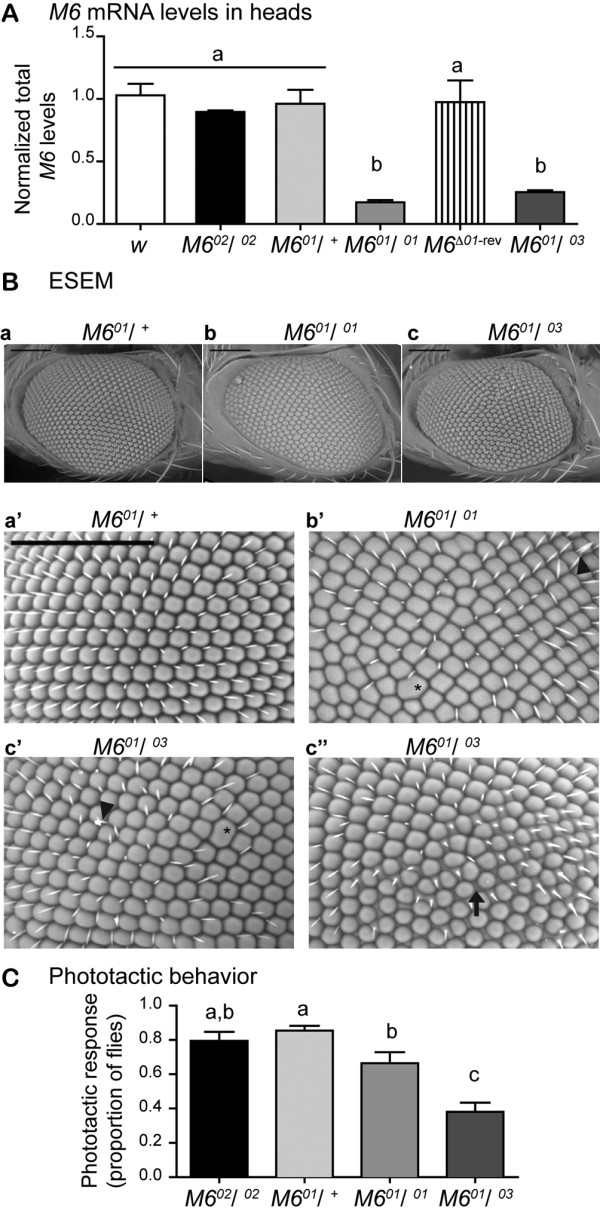
M6downregulation triggers a mild rough eye phenotype and impairs the phototactic response. (A) M6 mRNA levels in heads of control (w), M602/ 02, heterozygous and homozygous M601, M6Δ01-rev (M601 P-excised), and the trans-heterozygous M601/ 03 mutants were assessed by RT-qPCR. The values shown are relative to the control genotype (white bar). Mean ± SEM, n = 3–5. Kruskal-Wallis test, p < 0.001, followed by a multiple comparison test. Different letters indicate significant differences. (B) Representative images of young male fly eyes taken with an environmental scanning electron microscope (ESEM). Eyes of heterozygous M601/ + used as control (a, a’), homozygous M601/ 01 (b, b’) and trans-heterozygous M601/ 03 (c, c’ and c”) are shown. Lower and higher magnifications are displayed in the upper and lower panels, respectively. In addition to the disorganized ommatidium array, alterations in the ommatidial shape or fusions between contiguous ommatidia (asterisks) and bristle defects (arrowheads) are indicated. Altered interommadial space was detected in around 20 % of M601/ 03 mutants (arrow, c”). The ventral-dorsal axis is oriented left to right; scale bar is 100 μm. (C) Young male flies were assessed for their response to light in the phototaxis behavioral paradigm. Mean ± SEM, n = 5 independent experiments. Statistical analysis included a two way ANOVA (p < 0.0001) followed by a Newman-Keuls multiple comparison test between genotypes.